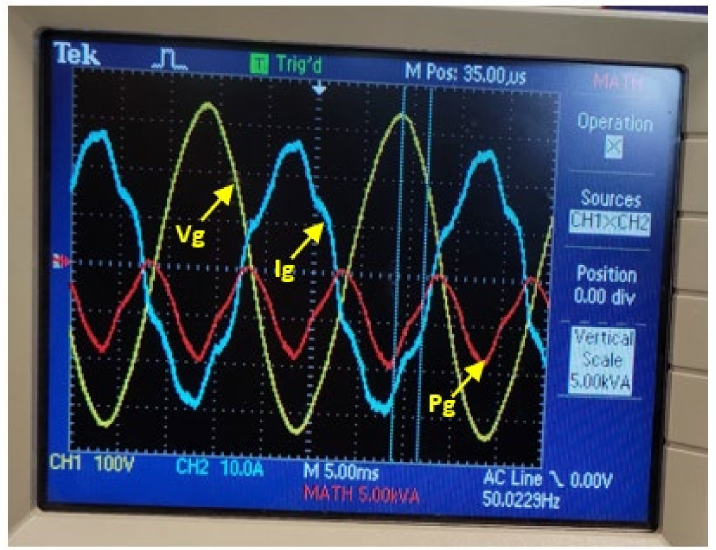
Figure 11. Measurement of AC voltage, current and power on the grid side. Here, Ig is grid current (Cyan), Vg is grid voltage (light green) and Pg is the instantaneous power (red).